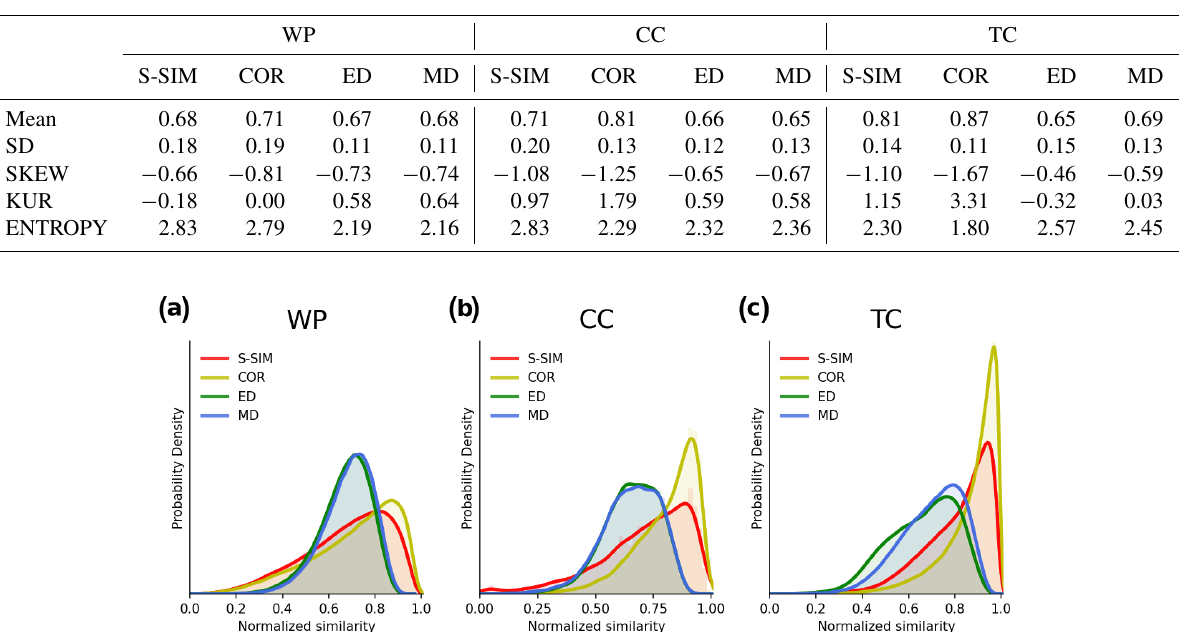
Table 1. Statistical metrics of S distributions for three demonstration input datasets, i.e., weather pattern (WP), climate change (CC), and tropical cyclone (TC). The different distance/similarity measures are structural similarity (S-SIM), the Pearson correlation coefficient (COR), Euclidean distance (ED), and Manhattan distance (MD). Statistical measures include the mean (Mean), standard deviation (SD), skewness (SKEW), kurtosis (KUR), and Shannon entropy (ENTROPY).